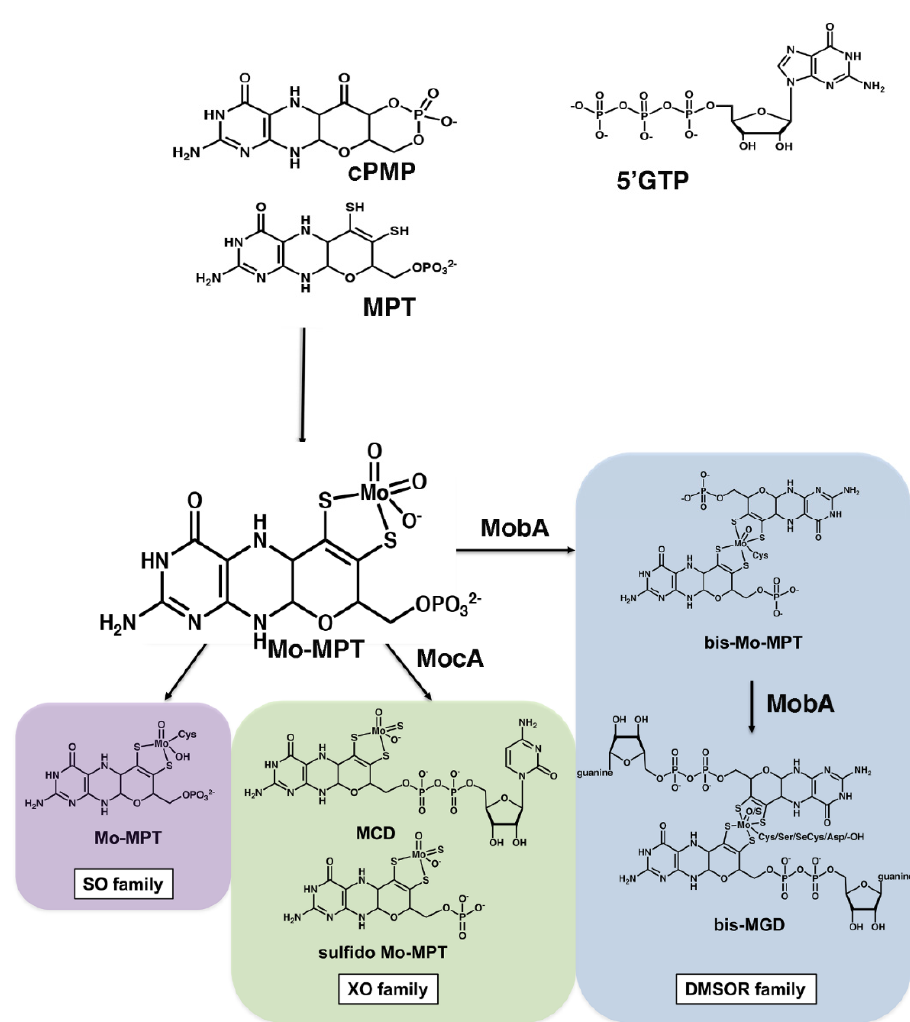
Figure 1. Different structures of Moco in bacteria. The basic form of Moco (Mo-MPT) is a 5,6,7,8- tetrahydropyranopterin (MPT) with a dithiolene group coordinating the molybdenum atom in a trioxo form. Moco exists in different variants and is divided into three enzyme families according to the coordination at the molybdenum atom: the SO family, the XO family and the DMSO reductase family. The SO family is characterized by a molybdenum ligation with one oxo, one hydroxide and one cysteine ligand from the protein backbone. In E. coli , the XO family contains the sulfurated molybdopterin cytosine dinucleotide cofactor (MCD), while in other bacteria the sulfurated form of Mo-MPT without an additional nucleotide has also been identified. The DMSO reductase family contains two MPTs (bis-Mo-MPT) or two MGDs (bis-MGD) ligated to one molybdenum atom with additional ligands being an O/S and a sixth ligand which can be a serine, a cysteine, a selenocysteine, an aspartate or a hydroxide ligand.